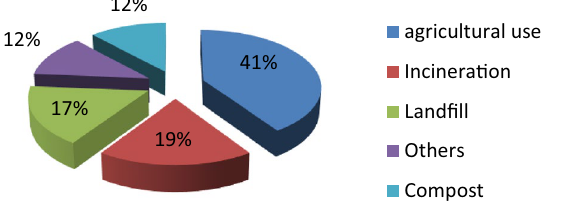
Fig. 2 Sewage sludge usage in Europe according to